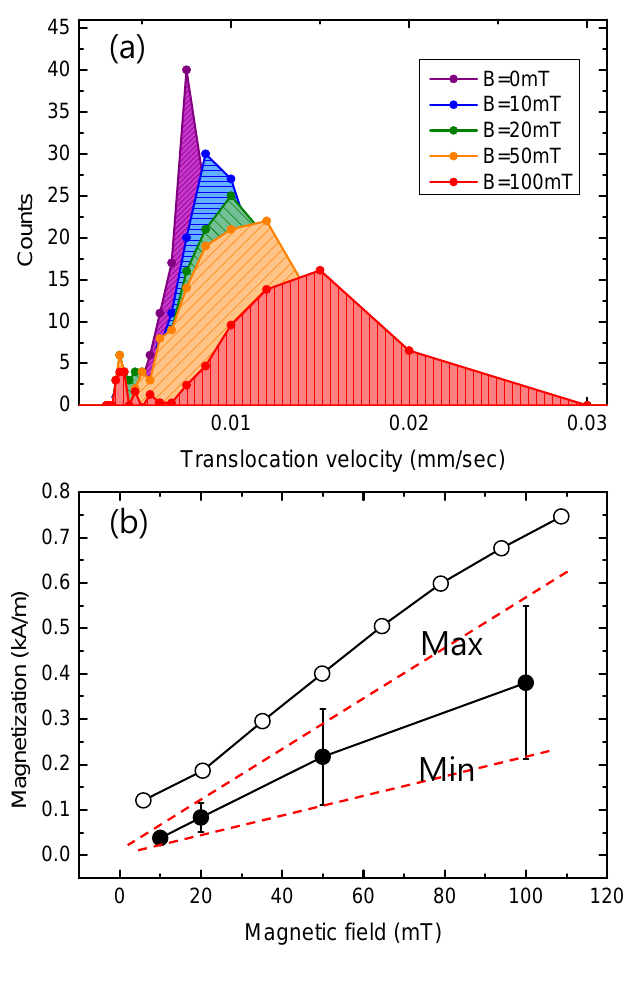
Figure 6. ( a ) Velocity distribution of the magnetic nanoparticles under various magnetic fields. ( b ) M-B curves obtained from VSM measurements (open circle) and ionic current measurements (closed